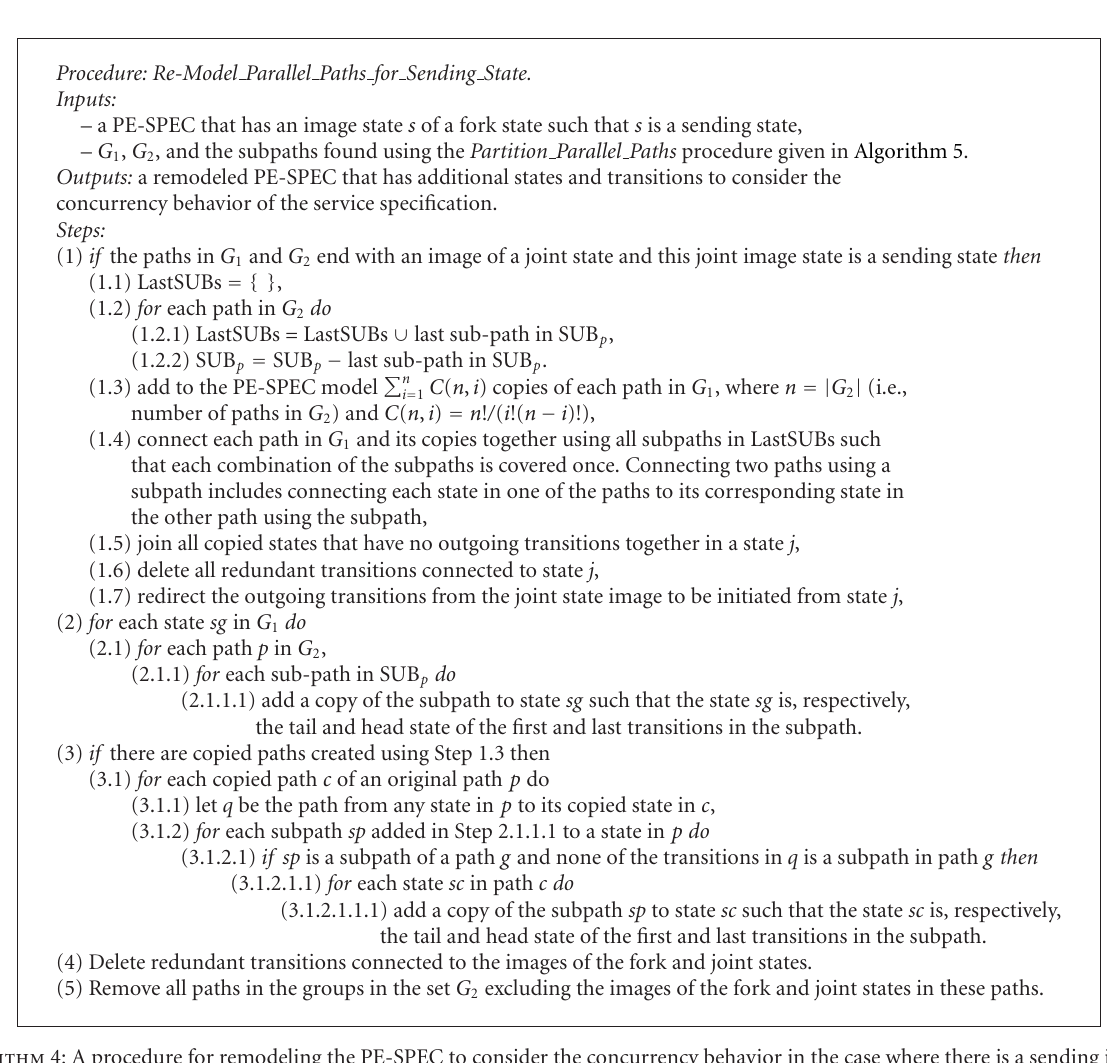
Algorithm 4: A procedure for remodeling the PE-SPEC to consider the concurrency behavior in the case where there is a sending image of fork